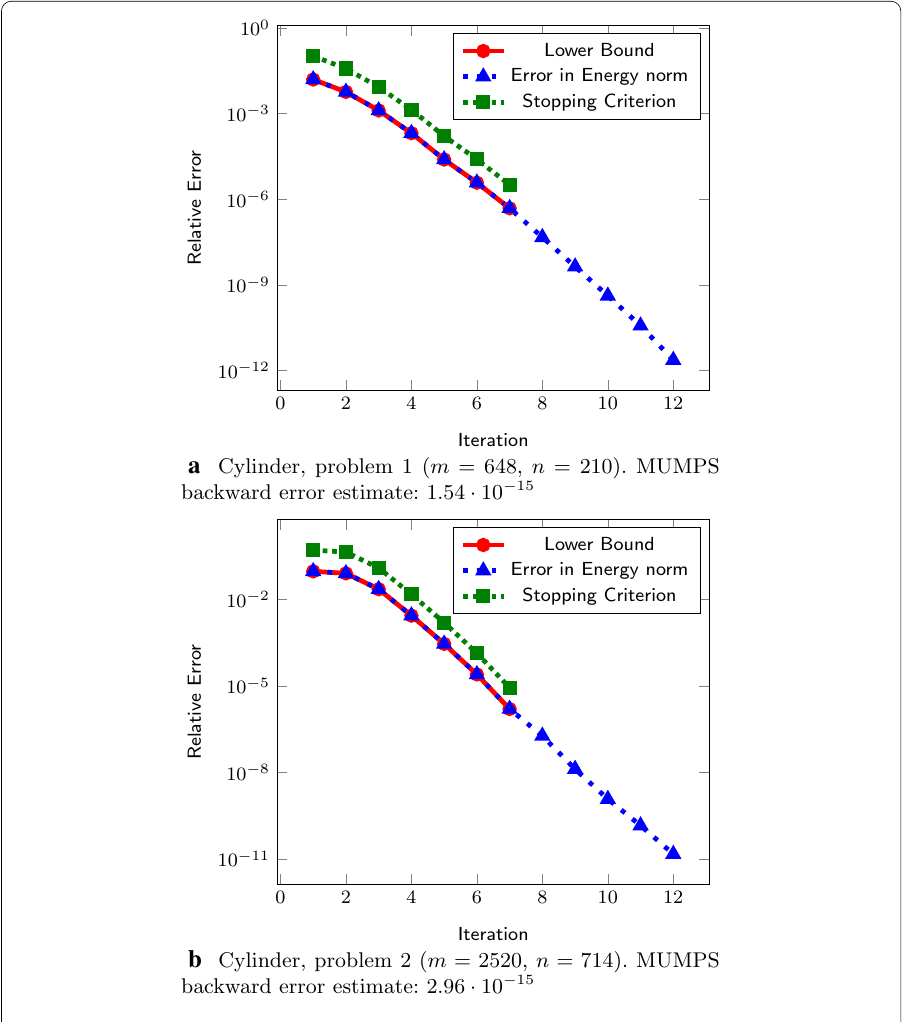
Fig. 3 Convergence of generalized GKB method for Cylinder problems 1 and